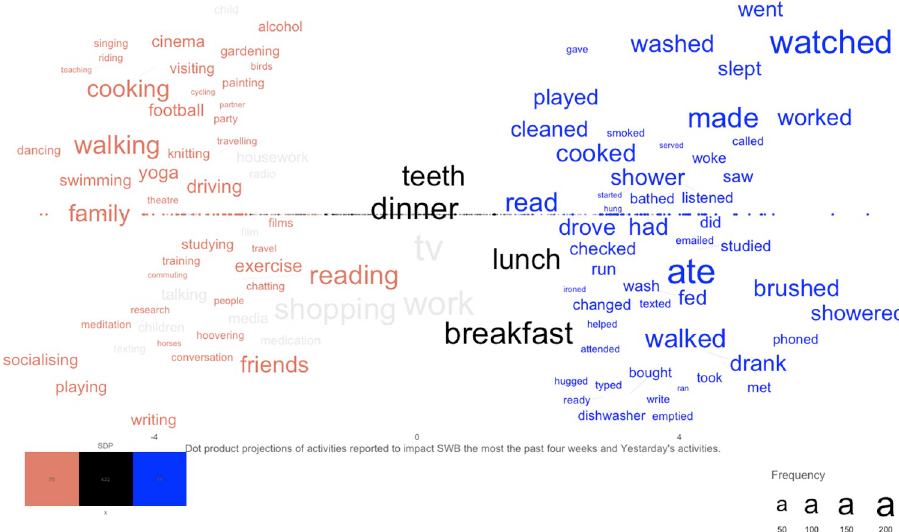
Fig 1. Activities reported to impact SWB the most the past four weeks and Yesterday’s Activities. Note : Supervised dimension projection plot for Yesterday’s Activities and activities that most affected the participants’ SWB in the past four weeks. The words appearing a minimum of 4 times in the questions, combined, have been significance tested against a permuted null distribution, N permutations = 100,000. Words significantly belonging to Yesterday’s Activities are plotted on the right side in blue. Words significantly related to activities having the greatest effect on the participants’ SWB in the past four weeks are plotted on the left side in red. Black words in the middle are frequent words not significantly belonging to any of the groups. Grey words belong to one word category but more frequently occur in the other category (with significant statistical support). Word size represents frequency. The position on the dimension projection (the position on the x-axis) represents the dot product score. For better visualization, the words are separated on the y-axis, but the y-axis does not represent any information.